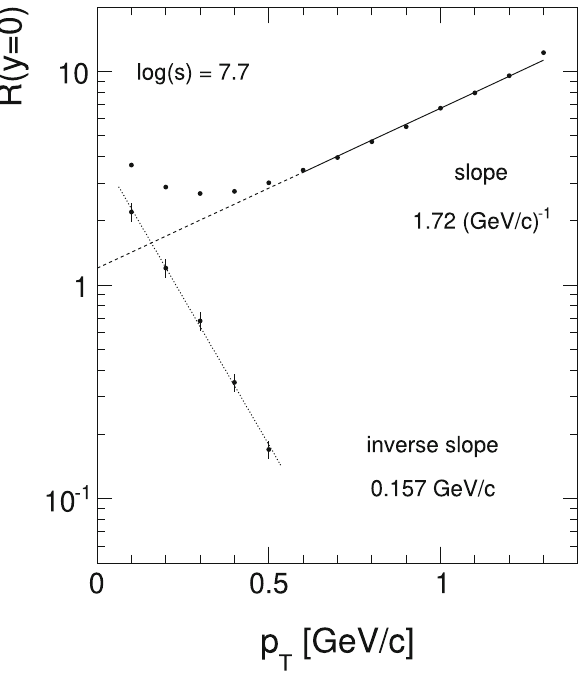
Fig. 123 R ( y = 0 , s , p T ) as a function of p T for log ( s ) = 7.7 with exponential fit to p T > 0.6 GeV/c, extrapolation to low p T (broken line) and subtracted ratio (dotted line) using the p T distribution from NA49 at y = 0 with its inverse slope of 0.17 GeV/c, Fig. 127a, and finally into the m T − m distribution of Fig.